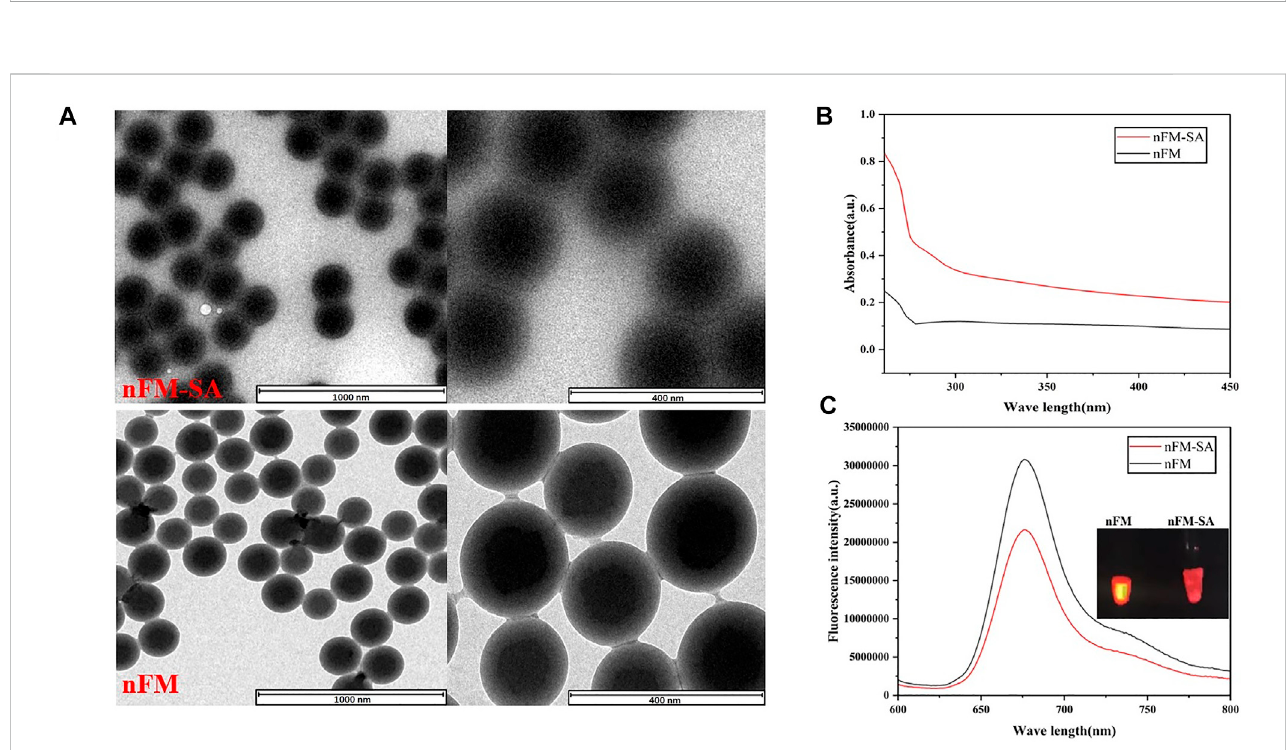
FIGURE 4 Characterization of nFM and nFM-SA conjugates. (A) Transmission electron microscopy (TEM) images of synthesized nFM and nFM-SA conjugates, (B) Ultraviolet visible (UV – vis) absorption, and (C) fl uorescence emission spectra of free nFM and nFM-SA conjugates.